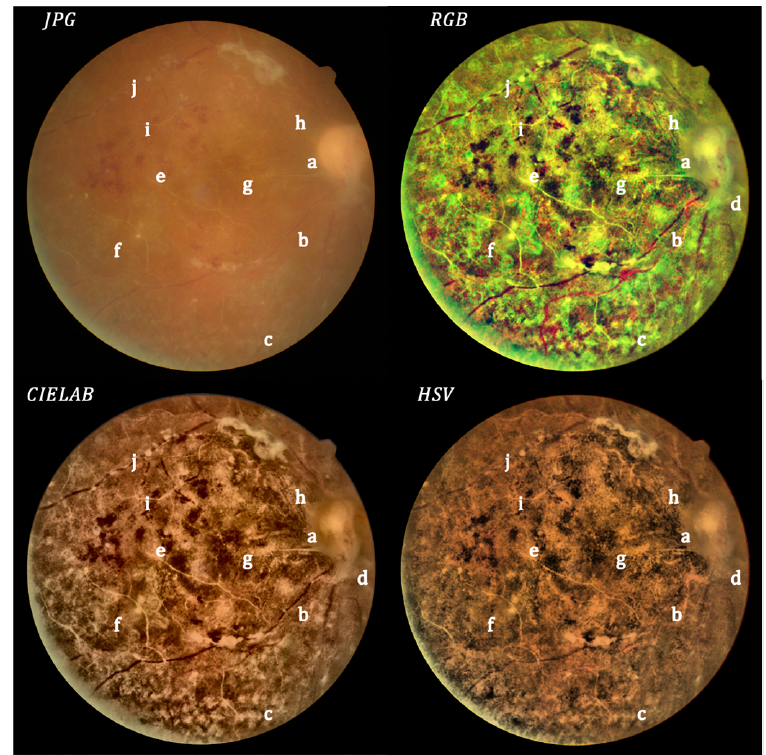
Figure 7. Moderate cataract: original (upper left) and processed images.